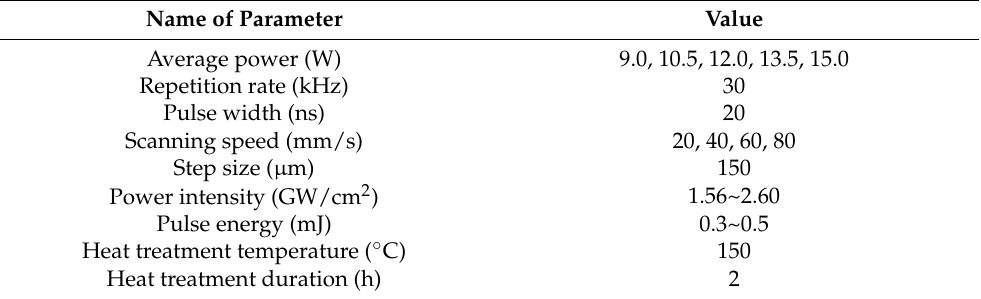
Figure 1. Pattern designs used for laser surface texturing of BMG: ( a ) unidirectional; ( b ) cross-hatch. Table 1. Processing parameters for the laser-based surface texturing